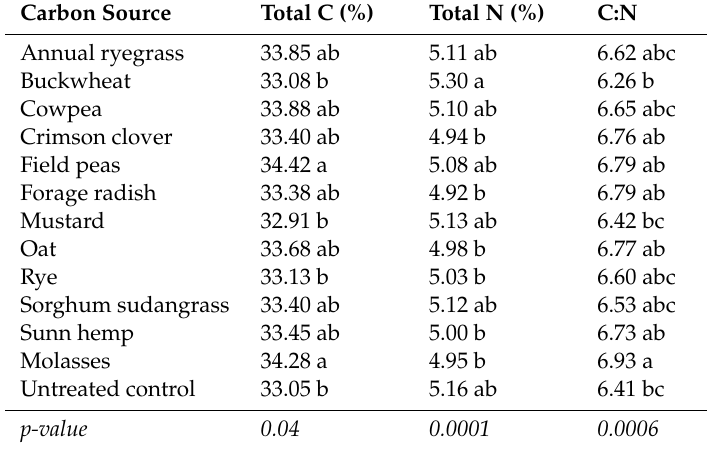
Table 8. Total carbon (C), total nitrogen (N), and C:N ratio at harvest (24 DAP) of Salanova lettuce grown on anaerobic soil disinfestation treated soil amended with alternative C sources 1